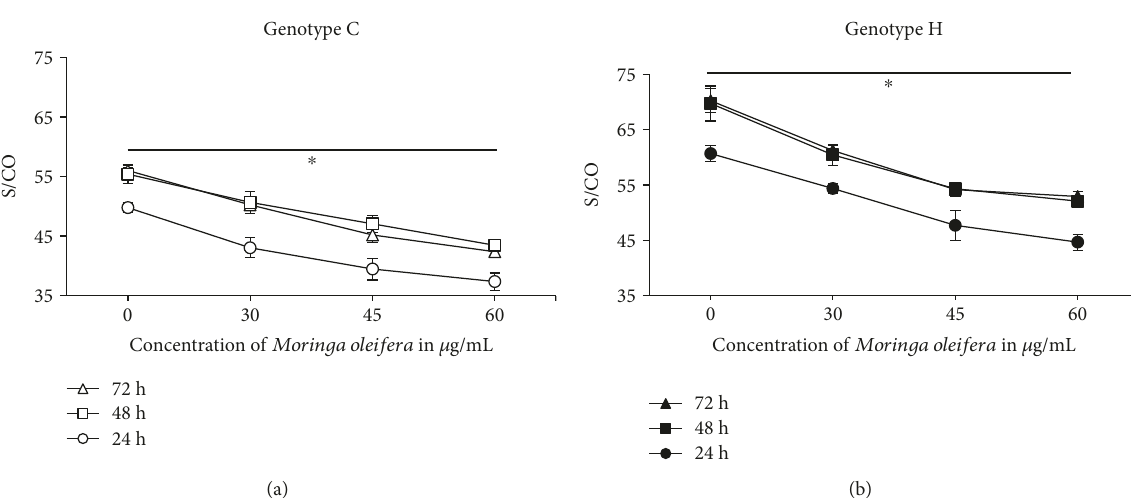
Figure 2: HBsAg secretion after Moringa oleifera treatment. Huh7 cells transfected with genotype C (a) and genotype H (b) of HBV and treated with 0, 30, 45, and 60 μ g/mL of Moringa oleifera . ∗ p < 0 05